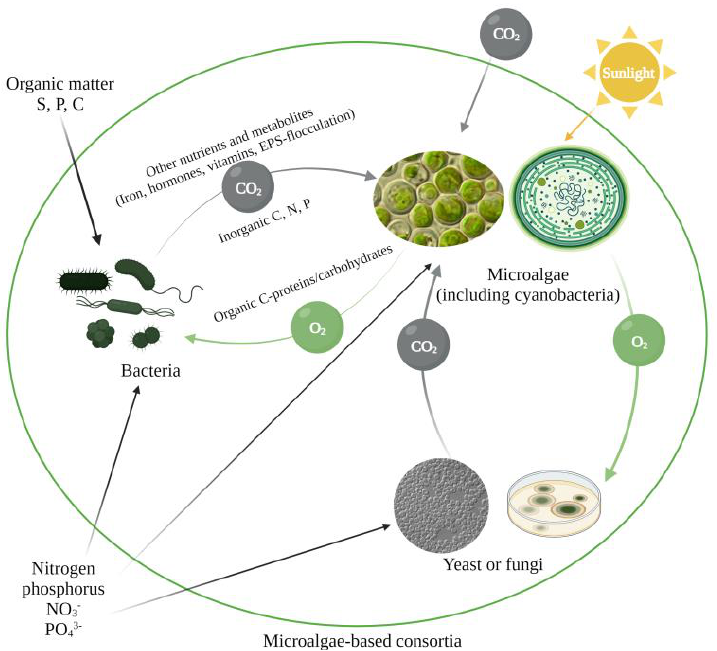
Figure 1. Schematic layout of the symbiotic principle of microalgae-based consortia. Microalgae and cyanobacteria can interact with various microorganisms, such as bacteria, yeast, and fungi. C, carbon; N, nitrogen; P, phosphorus; S, sulfur. (Modified from previous reports [5,13]).